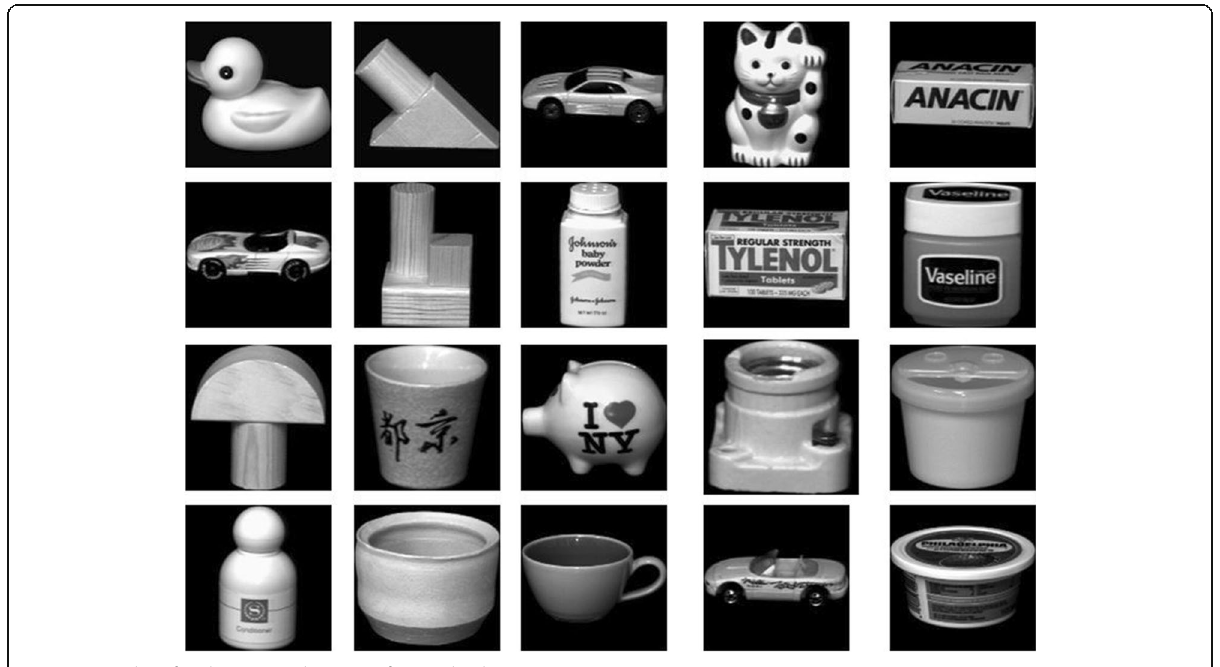
Fig. 16 Samples of Coil-20 grayscale images from Columbia University